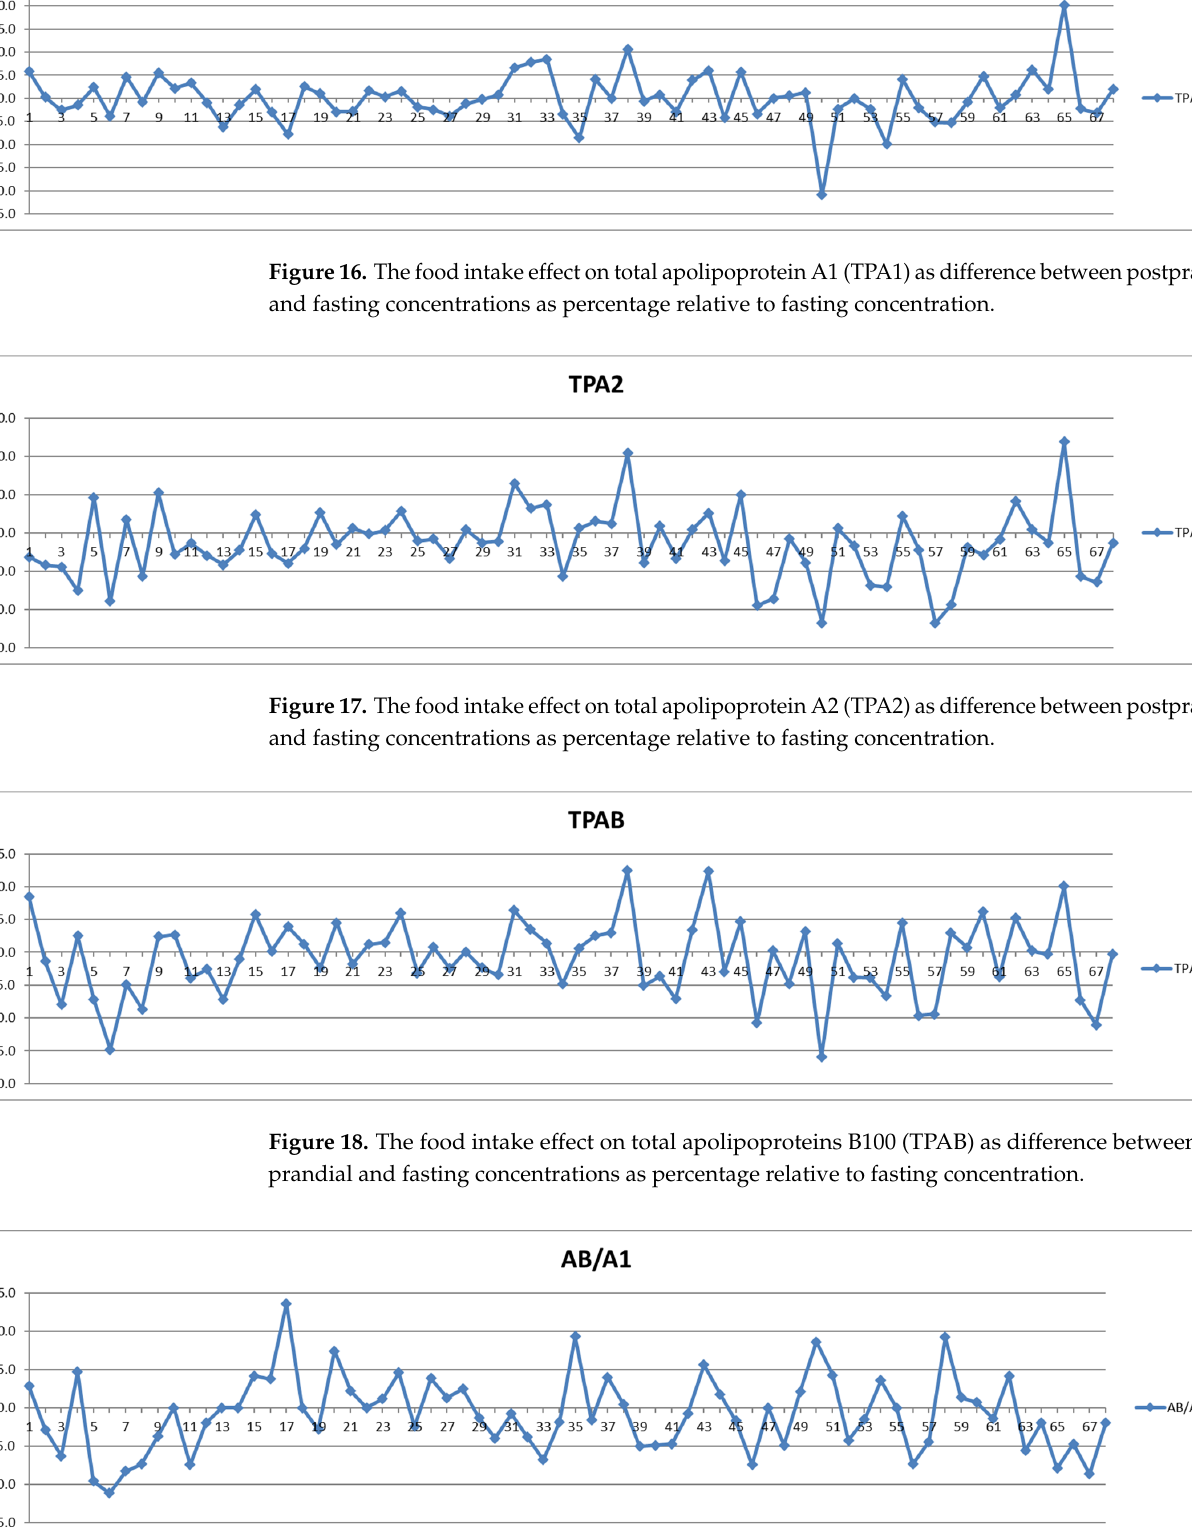
Figure 19. The food intake effect on Apo-B100/Apo-A1 (ABA1) as difference between postprandial and fasting concentrations as percentage relative to fasting concentration.